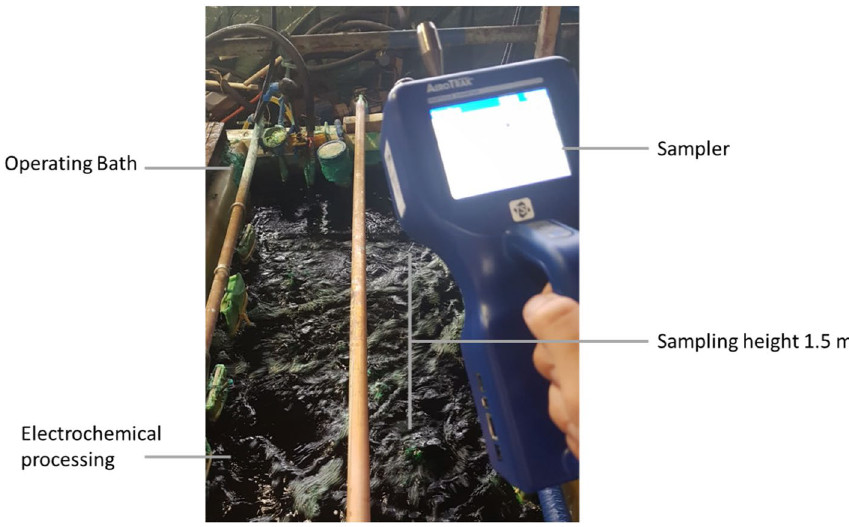
Figure 1. Sampling of industrial aerosol particles in the electroplating workshop. H = 1.5 m (Example).